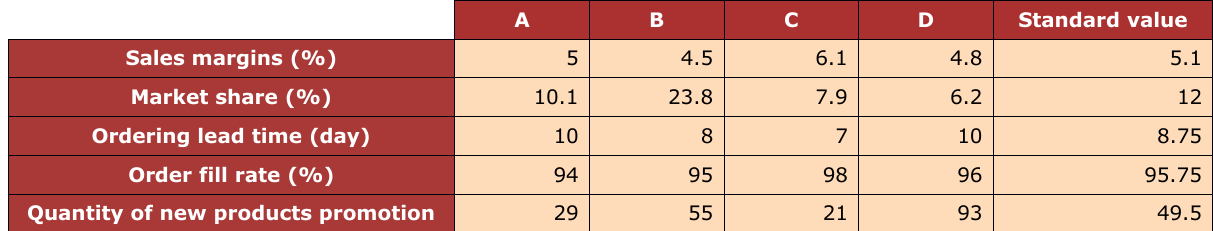
Table 1. Statistical data of relevant indicators